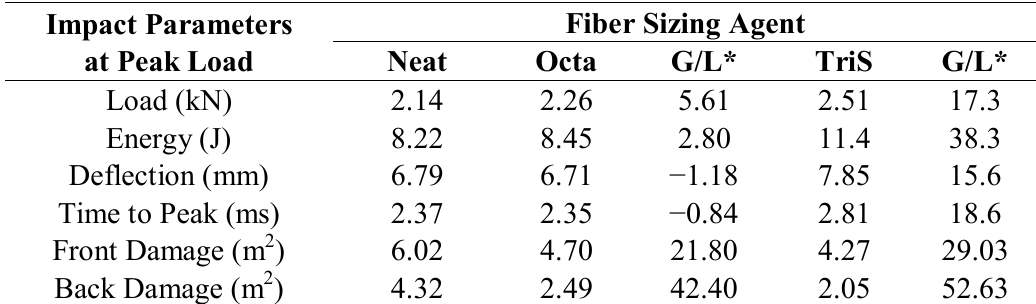
Table 2. Comparison of low velocity impact